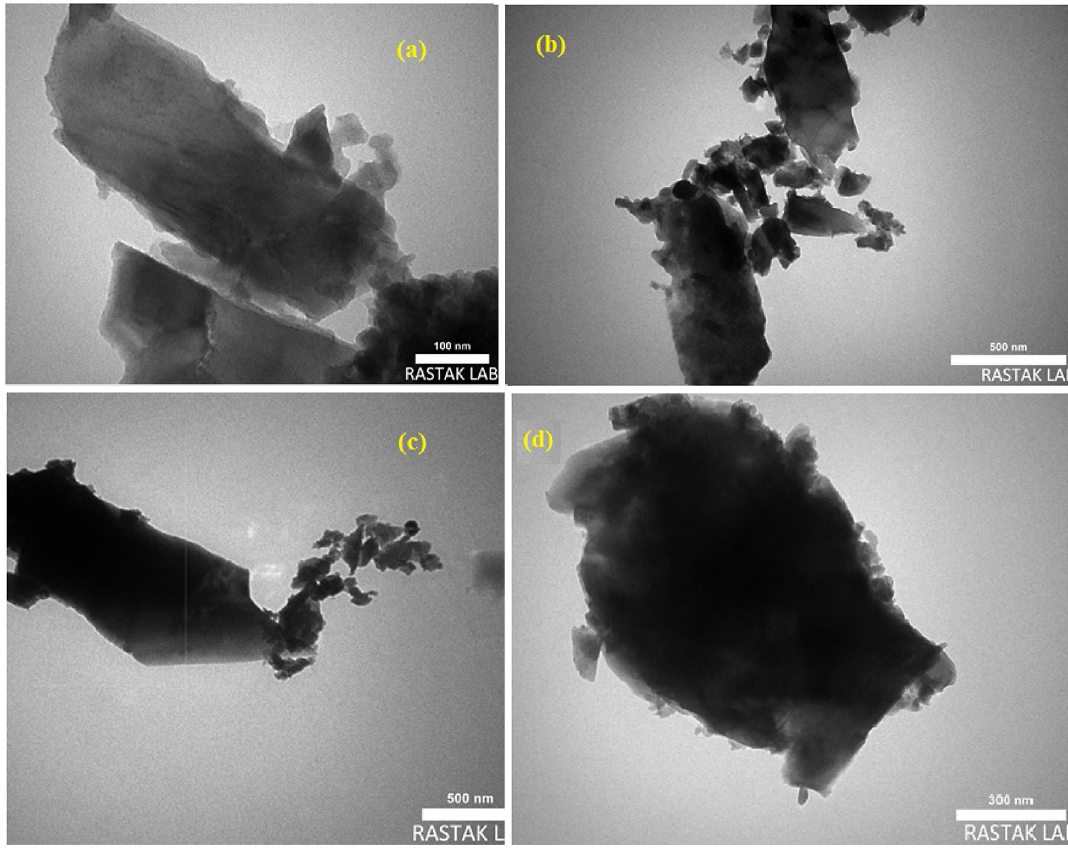
Figure 6. TEM images of Mo-metal–organic framework (MOF).